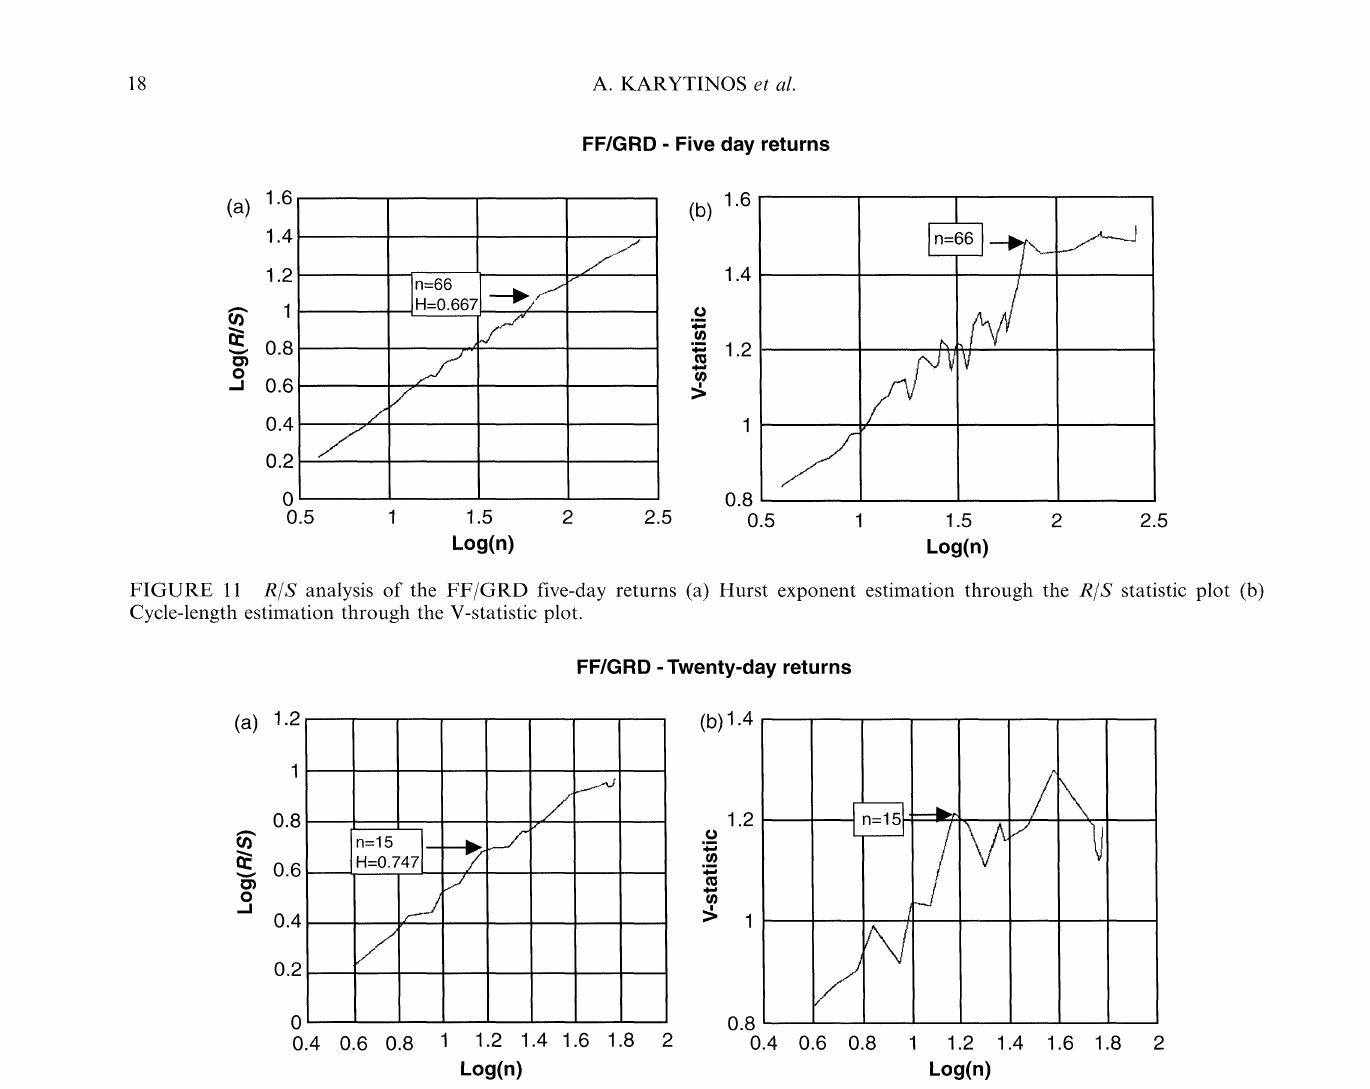
FIGURE 12 R/S analysis of the FF/GRD twenty-day returns (a) Hurst exponent estimation through the R/S statistic plot (b) Cycle-length estimation through the V-statistic plot. TABLE XV Hurst estimates and test of significance against the iid random alternative of the five-day and 20-day FF/GRD